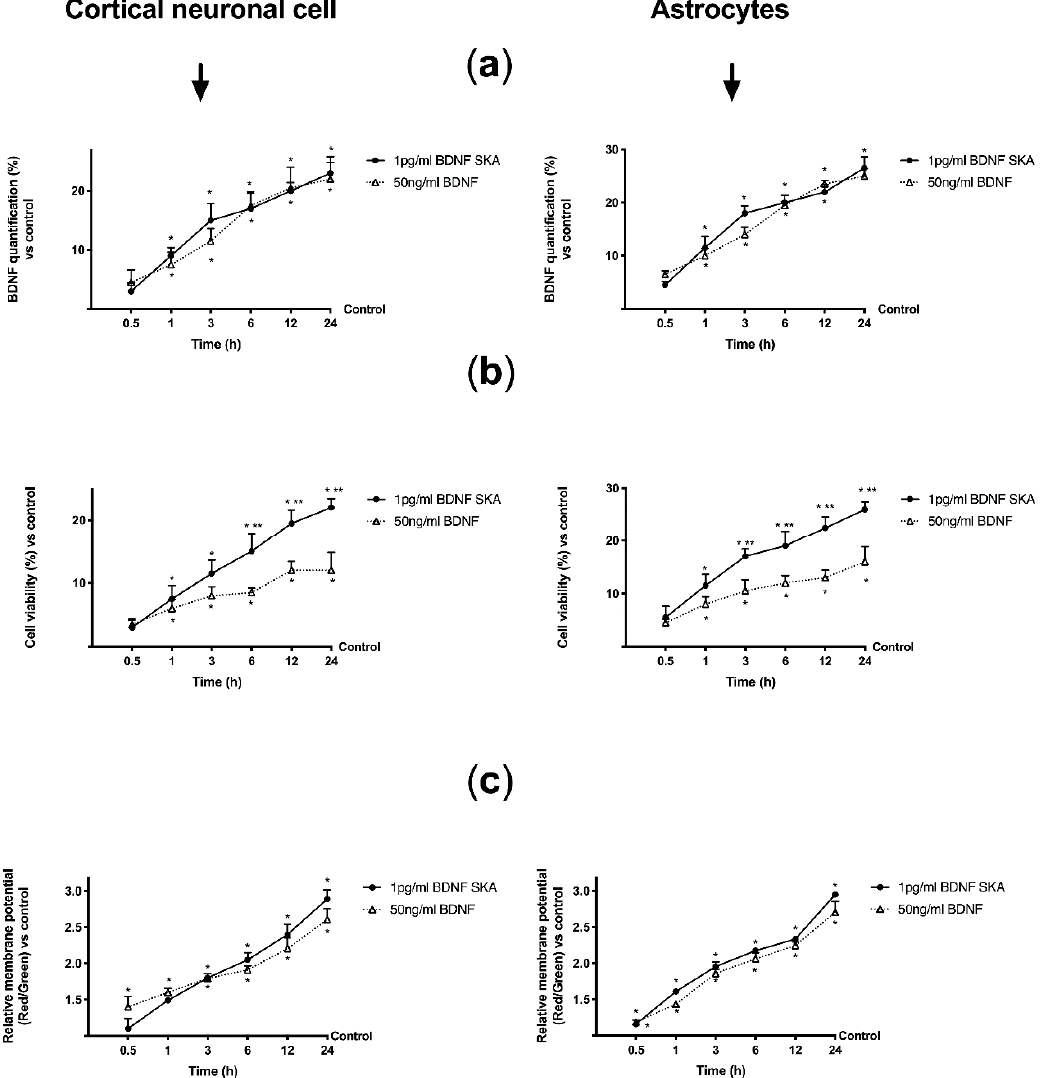
Figure 7. E ff ects of BDNF solutions within 24h on primary cortical neuronal cells and astrocytes. In the left column primary cortical neuronal cells and in the right column astrocytes are shown. ( a ) BDNF quantification and ( b ) cell viability measured after BDNF treatments. Data are expressed as means ± SD (%) of five independent experiments performed in triplicates normalized to control (0 line as control). ( c ) The mitochondrial membrane potential is investigated in the same condition. Data are expressed as means ± SD of five independent experiments performed in triplicates normalized to control (1 line as control). * p < 0.05 vs. control; ** p < 0.05 between 1 pg / mL BDNF SKA and 50 ng / mL BDNF.